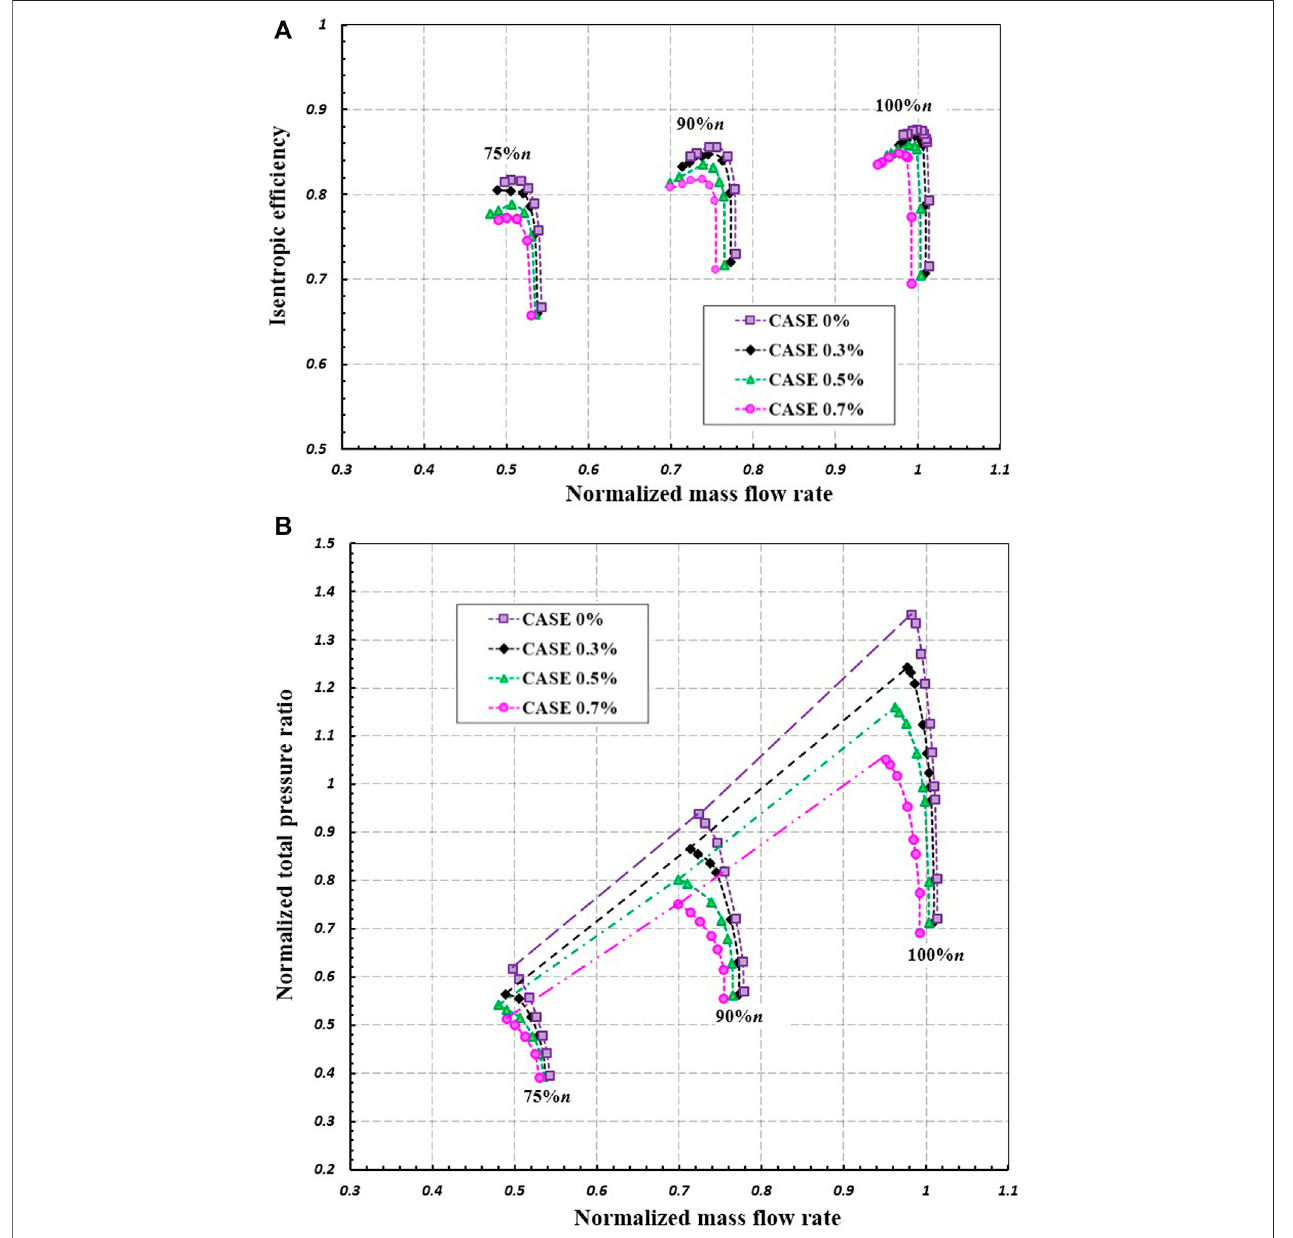
FIGURE7| Comparison ofcharacteristic curves forthecompressorperformanceon differentcases ofsealleakage.Characteristics ofisentropic ef fi ciency relative to normalized mass fl ow rate (A) , Characteristics of normalized total pressure ratio relative to normalized mass fl ow rate (B) .